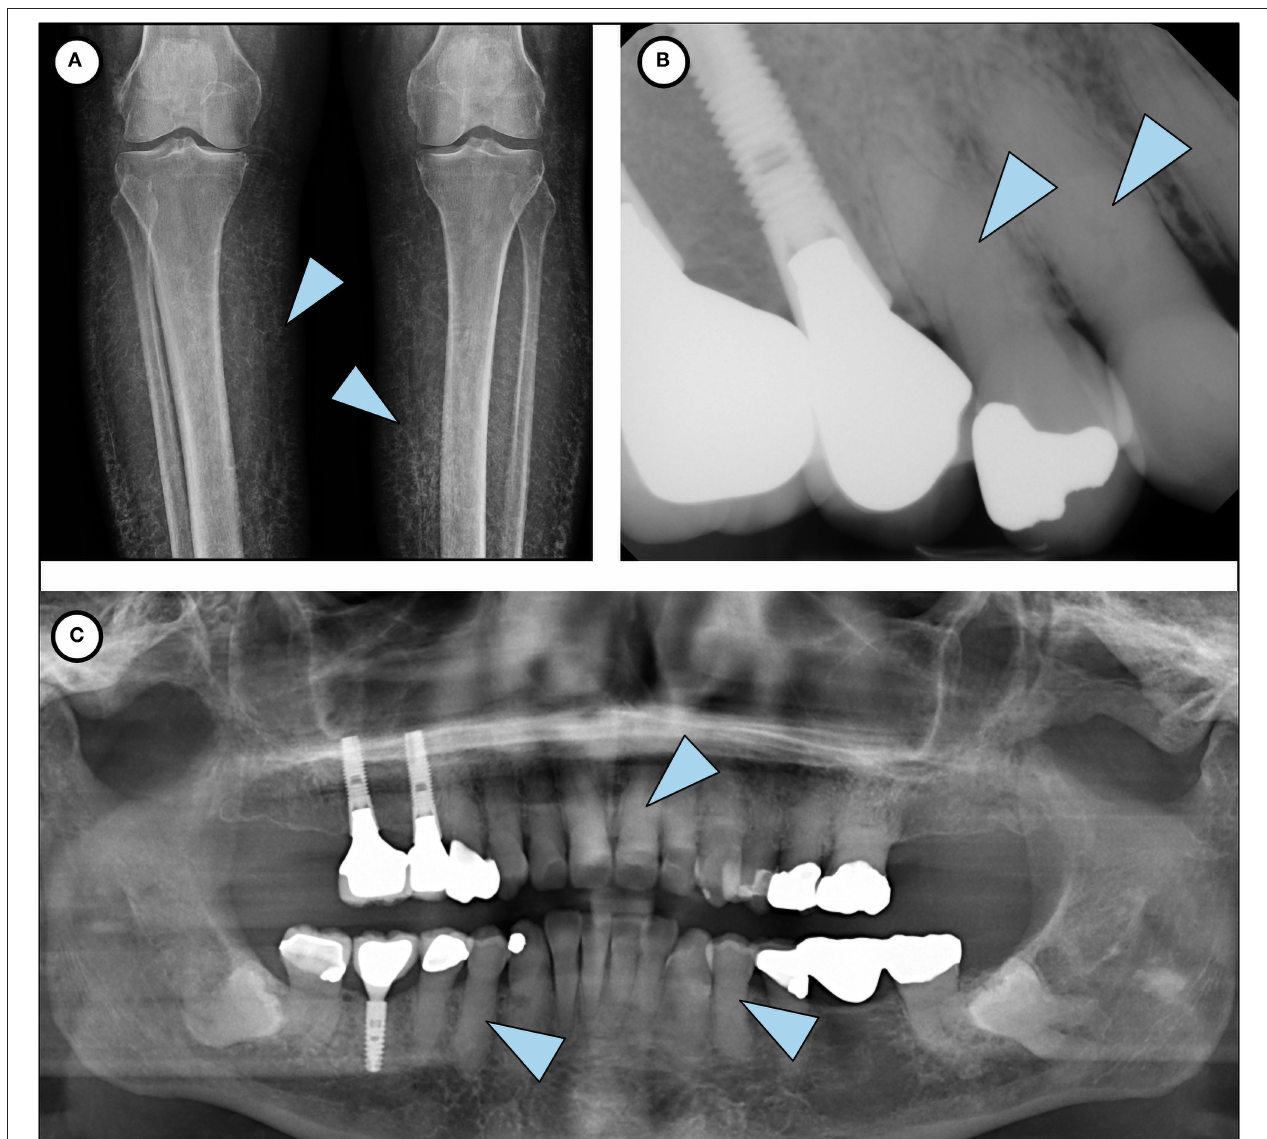
FIGURE 2 | Phenotypic features of HFTC. (A) Lower limb radiograph shows subcutaneous calcification of her legs, an unusual and rare finding seen in older patients with HFTC. (B) Periapical radiograph of teeth # 5 and 6 shows complete pulp obliteration and thistle-shaped roots. (C) Panoramic radiograph shows short bulbous root with complete pulp obliteration in all